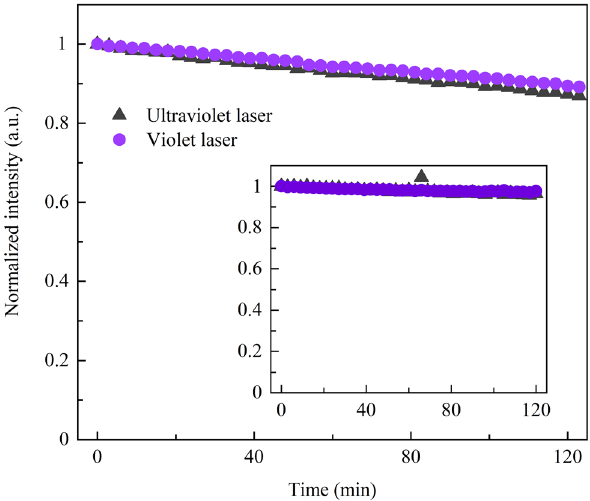
Figure 5: Intensity evolutions of the ultraviolet and violet lasers over the duration of 120 min. Inset: lasing intensity evolutions in another 70 μ m-diameter microsphere fabricated with the same doping